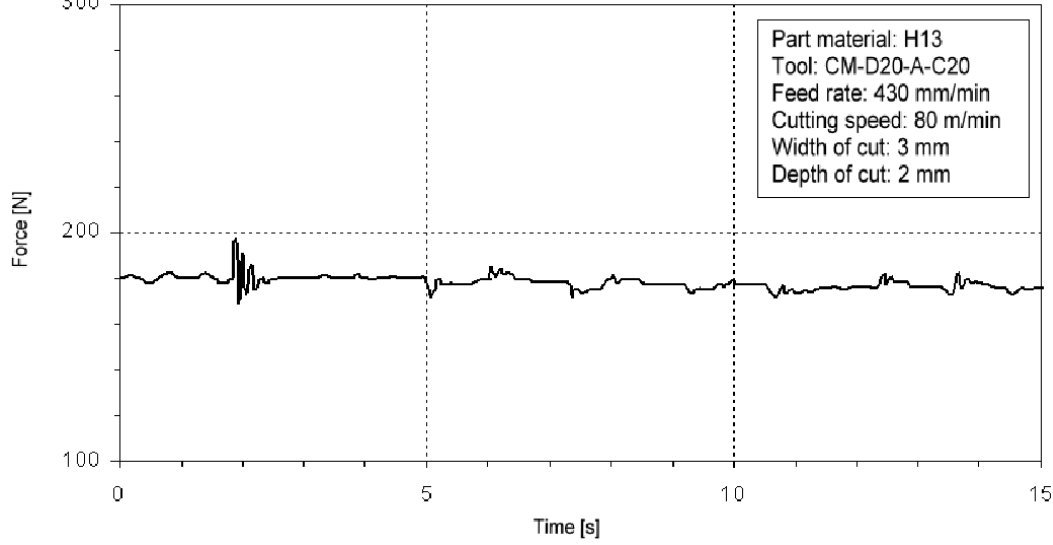
Figure 4. “Cutting force with PSO optimization”. Source: authors.